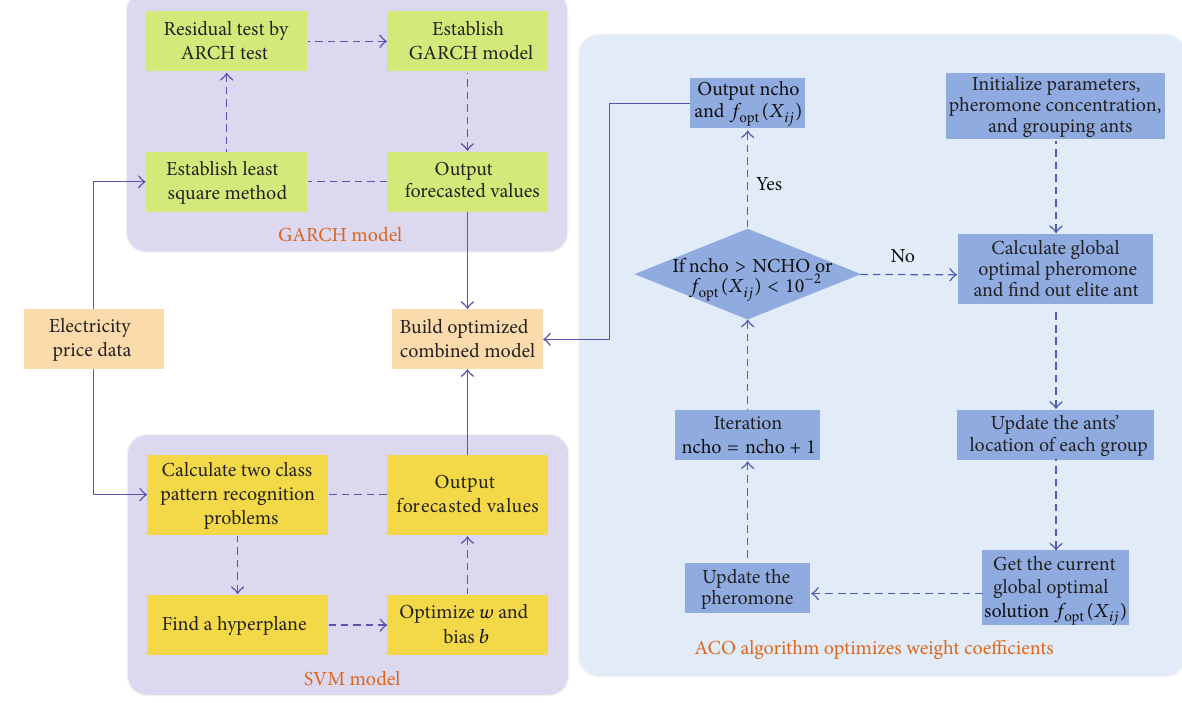
Figure 1: Flow chart of the optimized combined model.